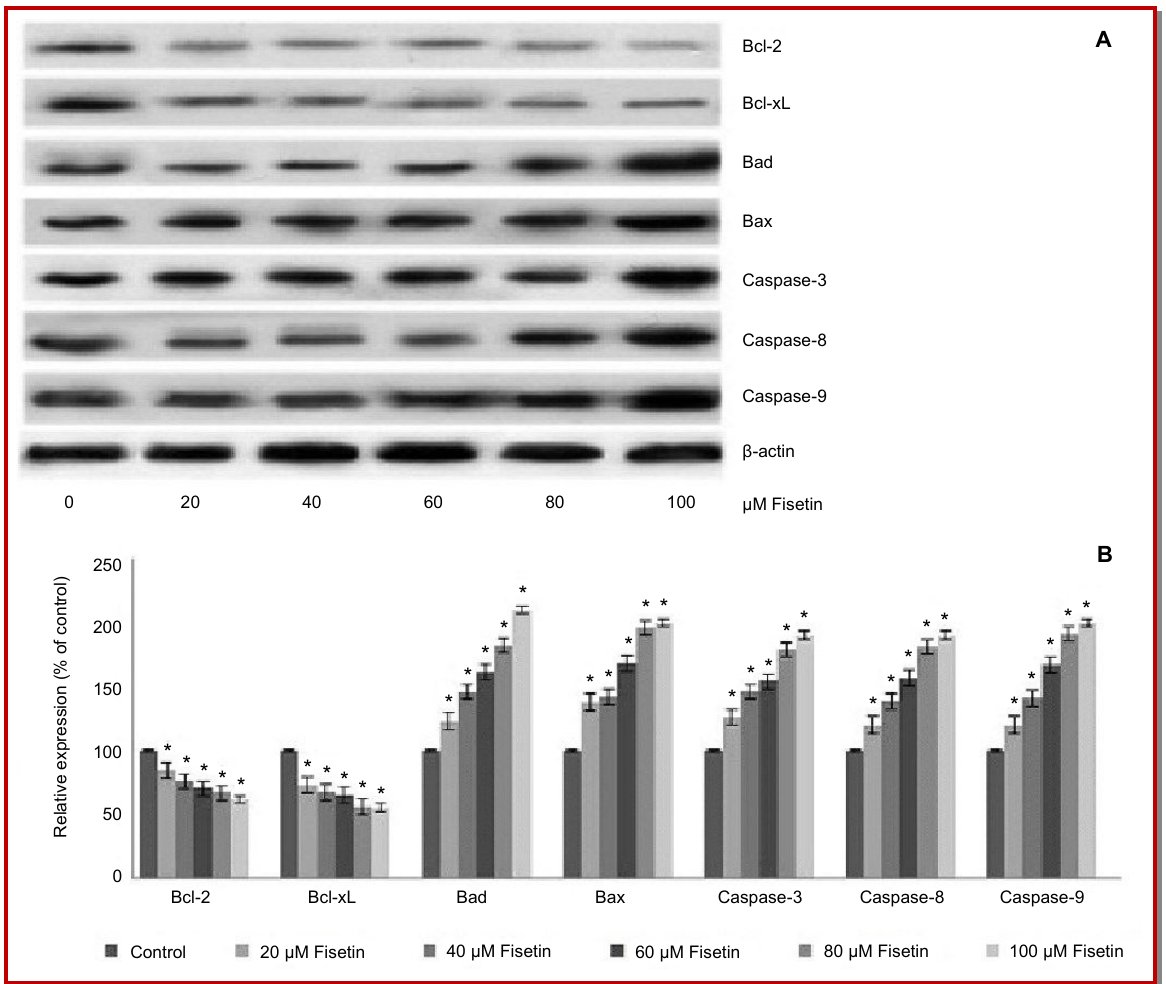
Figure 3: Influence of fisetin on the expression of apoptosis pathway proteins (A) Fisetin markedly up-regulated the pro-apoptotic proteins and reduced the expressions of Bcl-2 and Bcl-xL. (B) Relative expression of the proteins. Values are represented as mean ± SD; n=3; *represents p<0.05 compared with control as determined by one